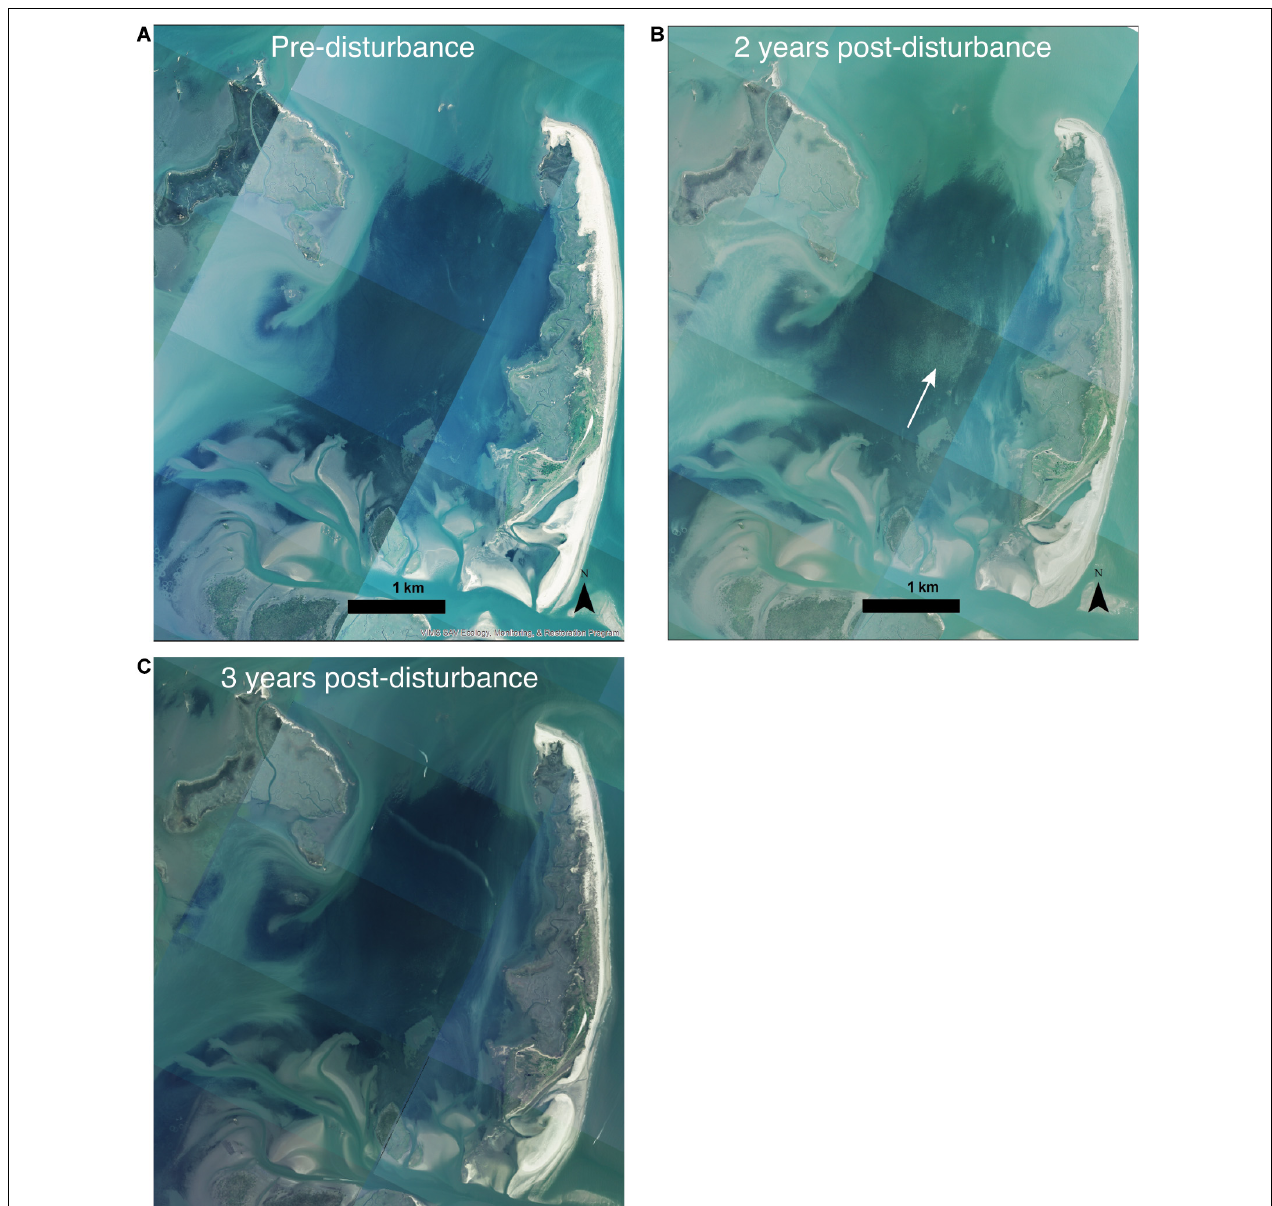
FIGURE 4 | Aerial images from before (A) , 2 years after (B) , and 3 years after (C) the MHW show spatial variability in the meadow status 2 years after the MHW and full recovery within 3 years. The white arrow in panel (B) indicates the area in the inner of the meadow that had low recovery 2 years after the